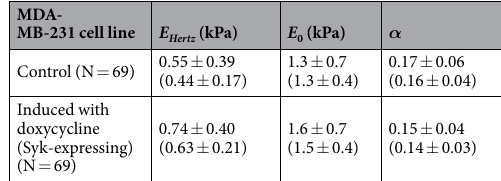
MDA- MB-231 cell line E Hertz (kPa) E 0 (kPa) α ± 0.39 Control (N = 69) 0.55 (0.44 ± 0.17)